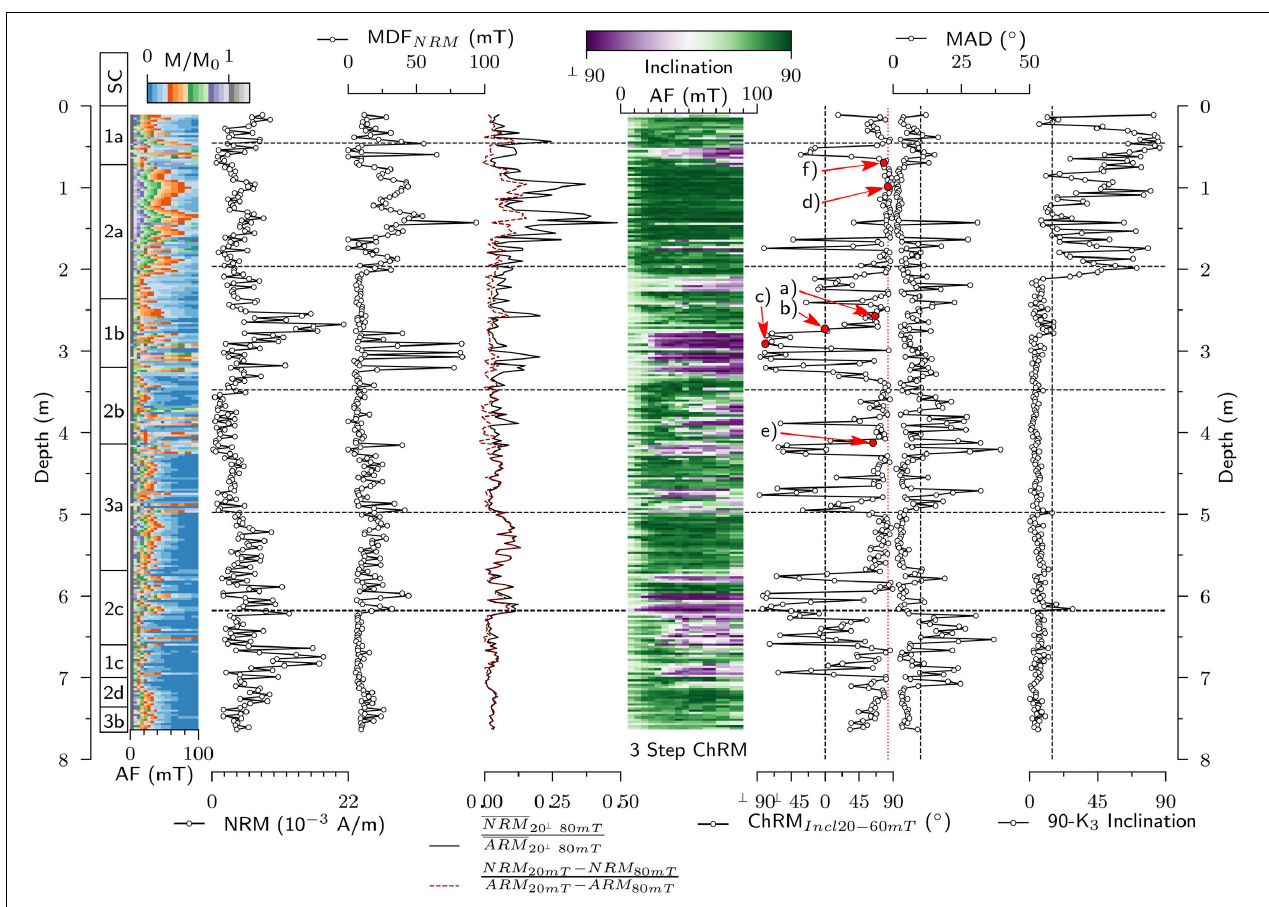
FIGURE 4 | Natural remanent magnetisation (NRM) and related parameters. From left to right: remaining intensity of NRM after each demagnetisation step normalised to NRM intensity, NRM intensity, median destructive field of the NRM, palaeomagnetic "stability" parameters, characteristic remanent magnetisation (ChRM) inclination based on 3-step principal component analysis (PCA), ChRM inclination (based on 20–60 mT PCA), median angular deviation (MAD) of PCA and 90 - K 3 inclination (inclination of axis of minimum magnetic susceptibility). Red dots in ChRM inclination mark positions of orthogonal projections in Figure 3